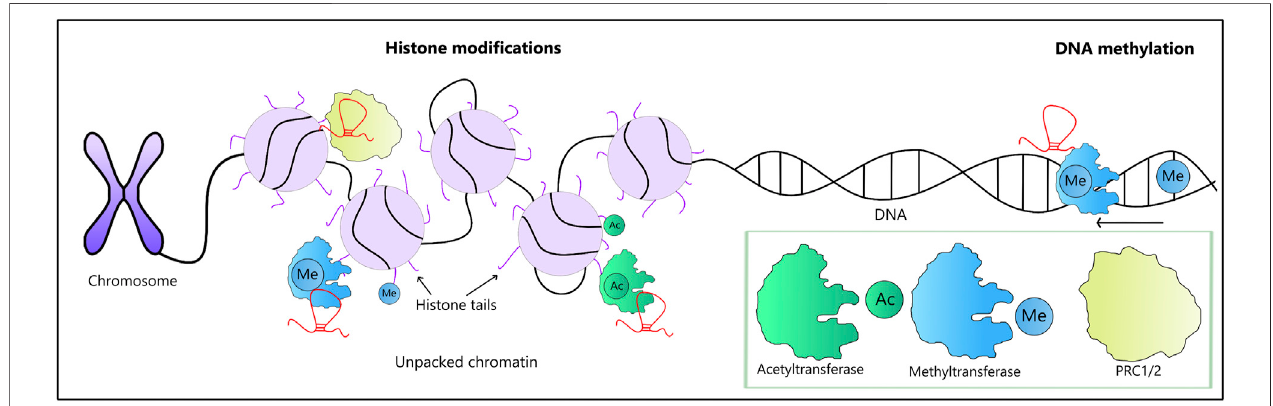
FIGURE 2 | LncRNA-mediated epigenetic modi fi cations along with the involved enzymes (a green box). Chromatin remodeling may be affected by lncRNAs interacting with remodeling enzymes, such as PRC1 and PRC2. These modi fi cations either enhance or suppress the activity of involved genes. Two types of histone modi fi cations are shown here: histone methylation carried out by methyltransferases (in blue) and acetylation carried out by acetyltransferases (in green), both of which are subject to modulation by lncRNAs. Of note, lncRNAs involved in DNA methylation may either enhance or suppress the process.